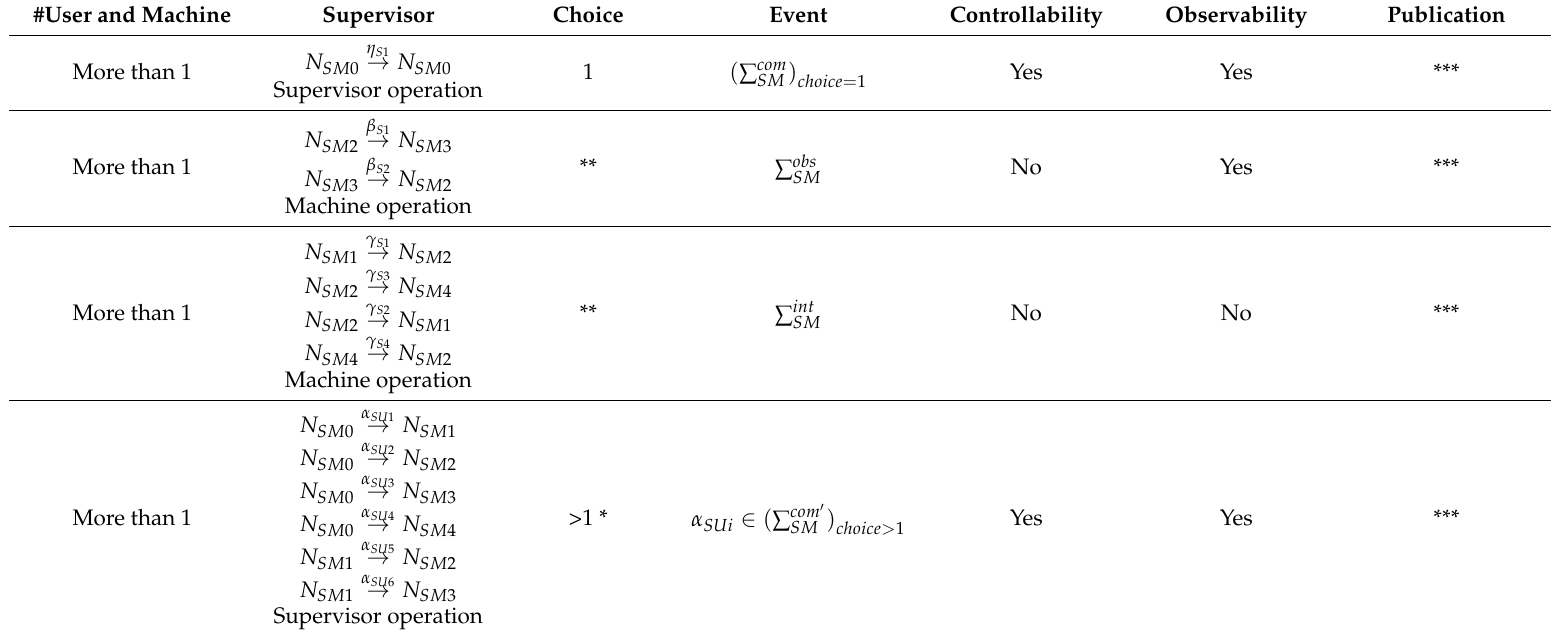
Table 2. Event execution based on criteria of observability and controllability through supervisor and supervisor machine operation. #User and